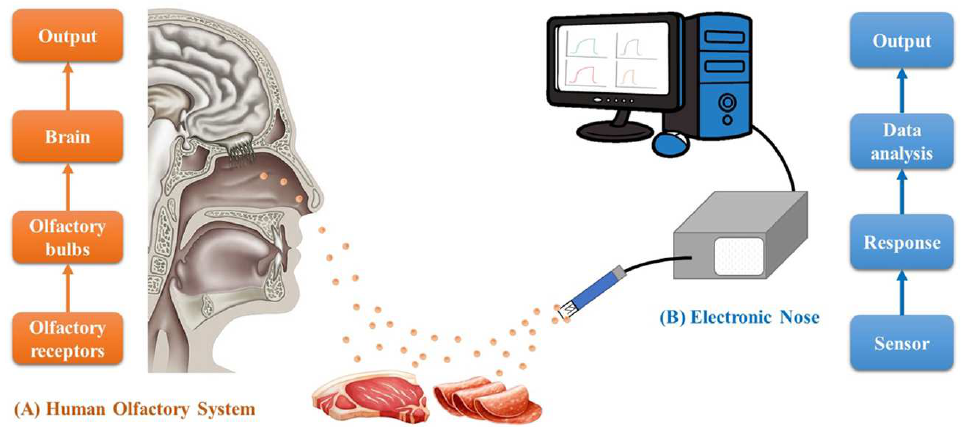
Figure 1. Schematic illustration of the biological olfactory system ( A ) and E-nose technology ( B ). The sensor array can be composed of many field-effect metal-oxide-semiconductor transistors with catalytic metal action gates or chemical sensors based on carbon dioxide brass, such as the so-called Taguchi sensors [24]. Additionally, it is possible to use E-nose tool